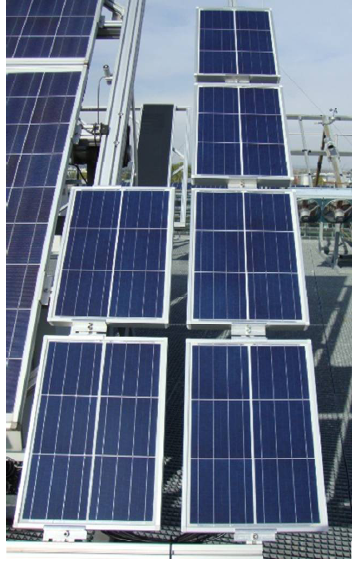
Figure 1. Outdoor test stand (Austrian Institute of Technology (AIT), Vienna, Austria).